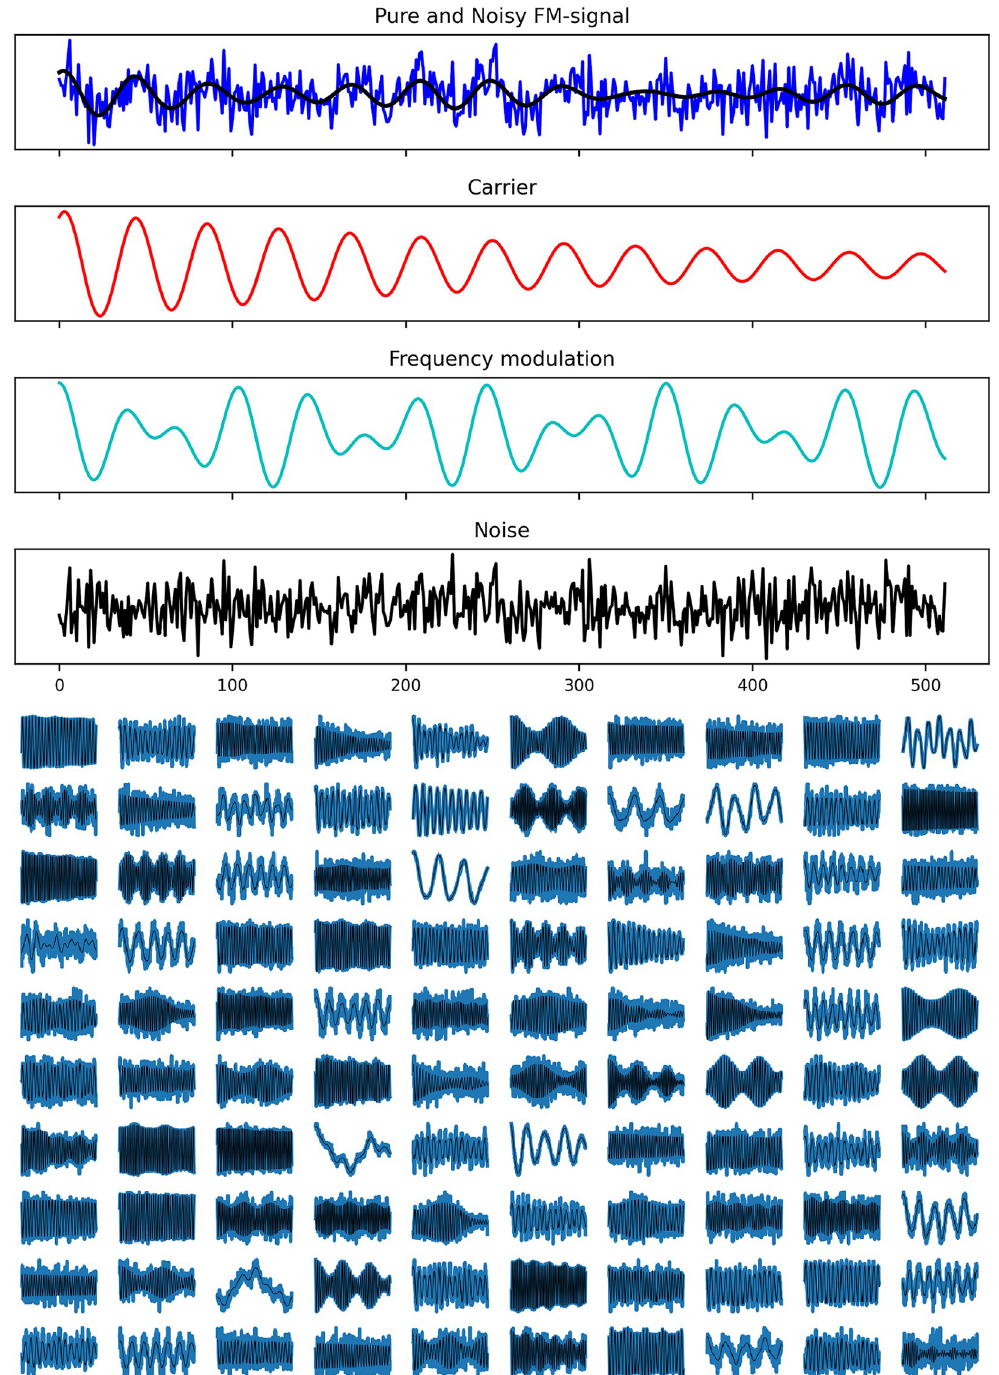
Fig 1. Examples of frequency-modulated sine wave (FM) synthetic time series. Top : pure and noisy FM-sine wave decomposition. Gaussian noise and frequency modulation are linearly added to decaying sine wave carrier. Bottom : random selection of noisy-input (blue) and pure-target (black) samples, illustrating the effect of the random latent parameter selection.